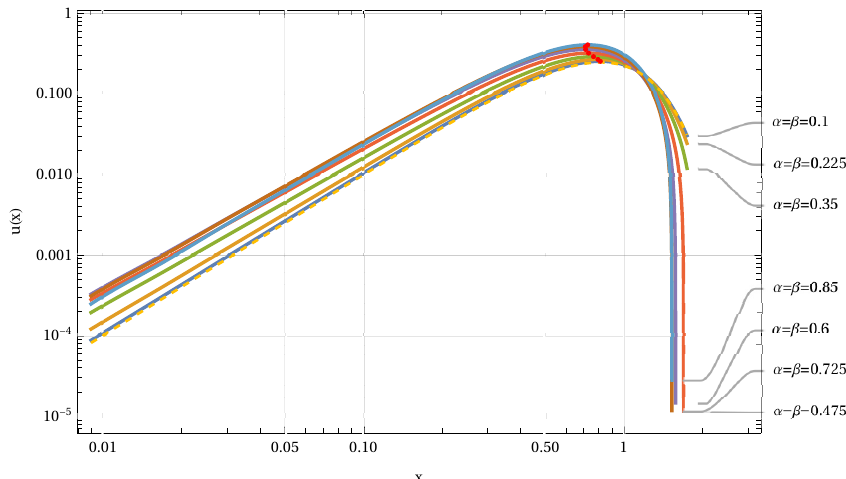
Figure 10. Solutions of Equation (47) represented by (51) for varying α = β (see inset) using an inhomogeneity of Maxwell-Boltzmann type f ( x ) = x 2 exp value for λ = 1. Number of Sinc points N =